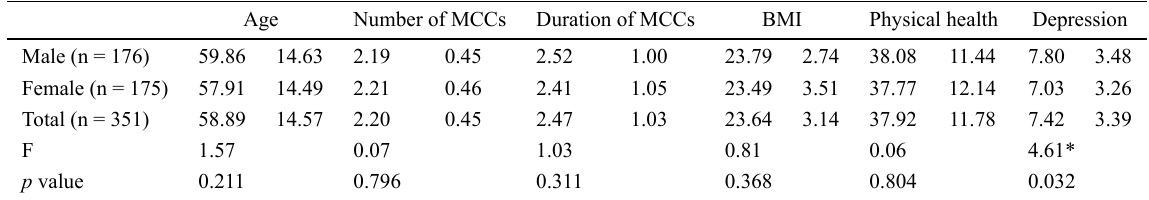
Table 1. Characteristics of the observed variables (n = 351).